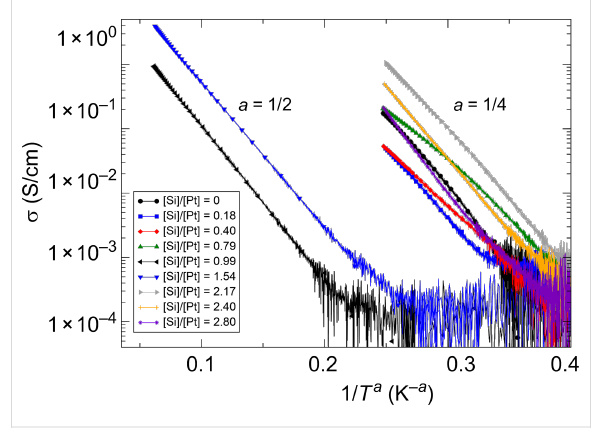
Figure 8: Temperature-dependent conductivity of the Pt–Si FEBID samples represented as ln σ vs T − a to facilitate comparison with VRH models according to Mott ( a = 1/4, three spatial dimensions) and for correlated VRH ( a = 1/2). The data are taken from Winhold et al.